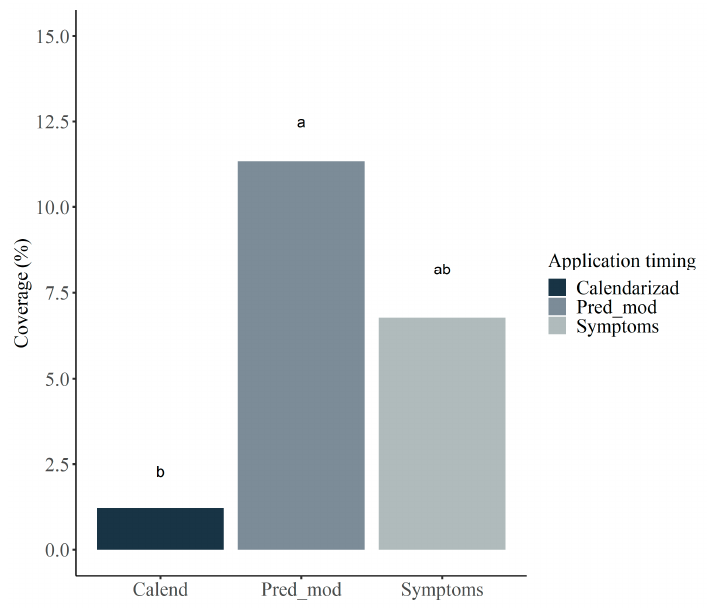
Figure 13. Mean percentage of coverage (%) in water-sensitive papers that were located at the lower region of the soybean canopy, according to different application timings in the second application of Field 2. The means followed by the same letter did not differ by the Tukey’s test at 5% probability ( p < 0.05).